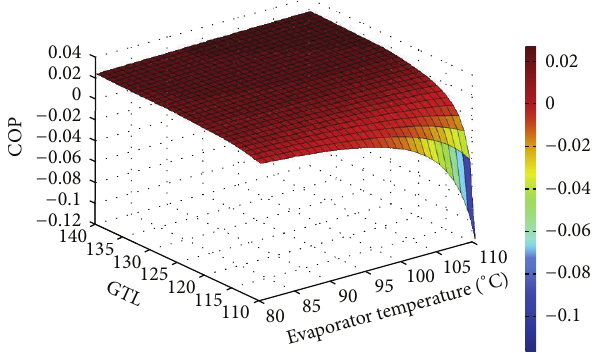
Figure 5: Effect of 𝑇